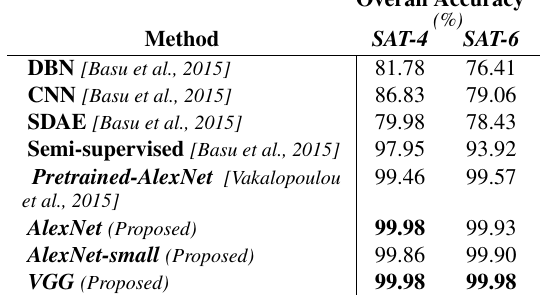
Table 4: Resulting classification accuracy and precision rates af- ter the application of the VGG model at both datasets without the NIR